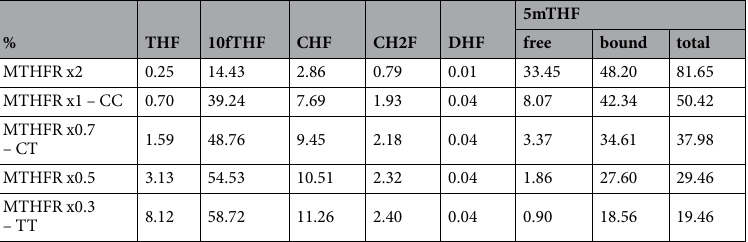
Table 1. Distribution of folate (in percentage of total folate) for different levels of MTHFR activity (ranging from 2x to 0.3x of wild type). CC, CT and TT refer to the C677T polymorphism.